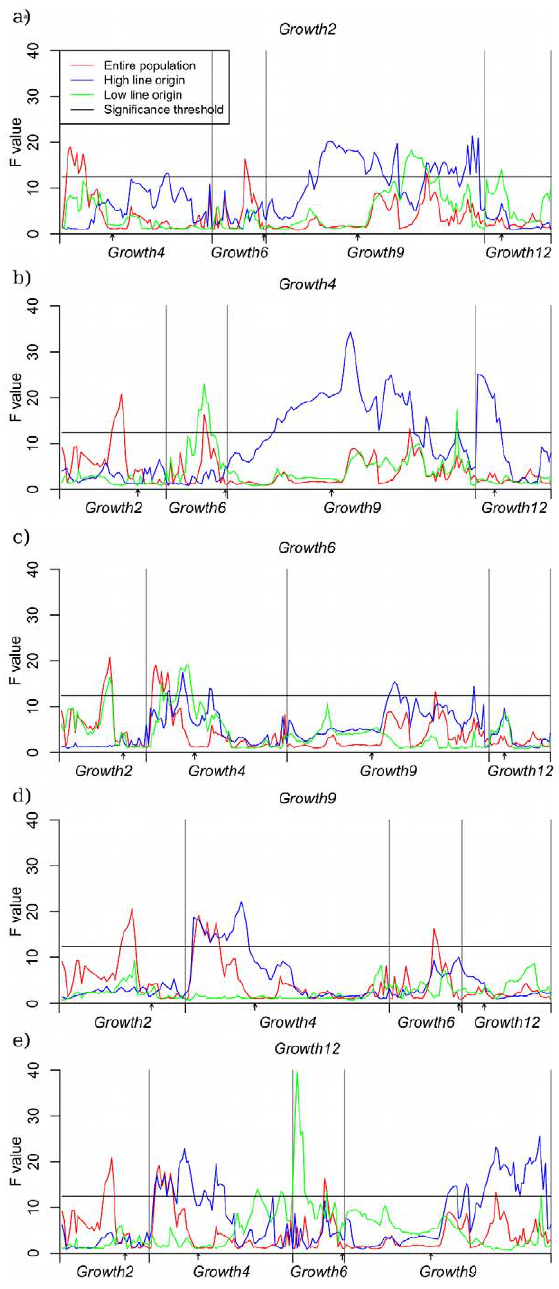
Figure 2. QTL scans on conditioned subsets of data. Panel a contains the scan where Growth2 is the conditioning locus, in b , c , d and e , the conditioning loci are Growth4 , Growth6 , Growth9 and Growth12 , respectively. Each panel shows the QTL profile in three data sets: HWS background (blue), LWS background (green) and the entire pedigree (red). Scans were performed for the non-transgressive loci in the radial network. The significance threshold represents 95% study-wide confidence based on a permutation test using 1000 replicates.